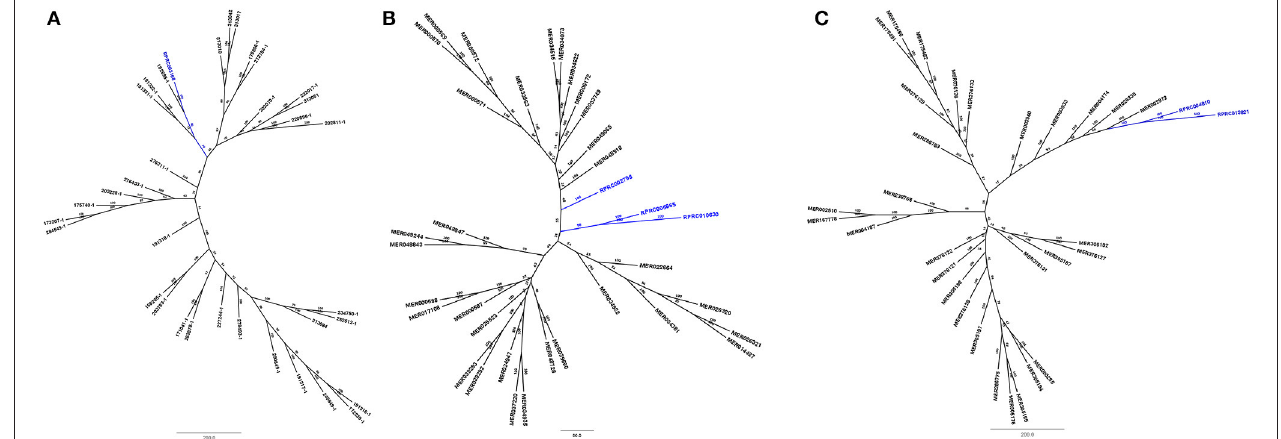
FIGURE 7 | Phylogenetic tree of amino acid sequences from peptidase families typical for microorganisms which present genes in Rhodnius prolixus genome. (A) Family M74 (Murein endopeptidase); (B) S24 (repressor LexA); (C) S29